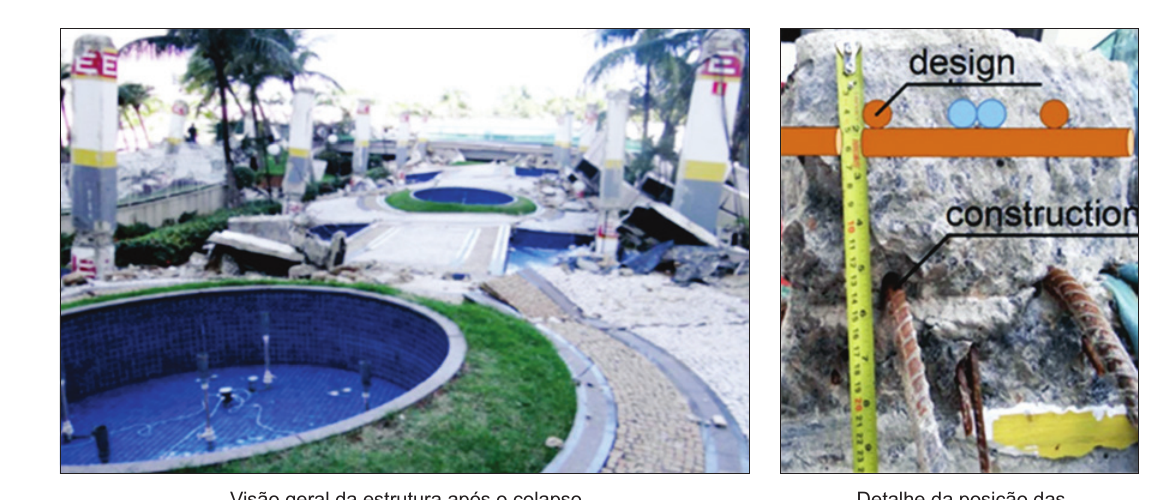
Visão geral da estrutura após o colapso Detalhe da posição das